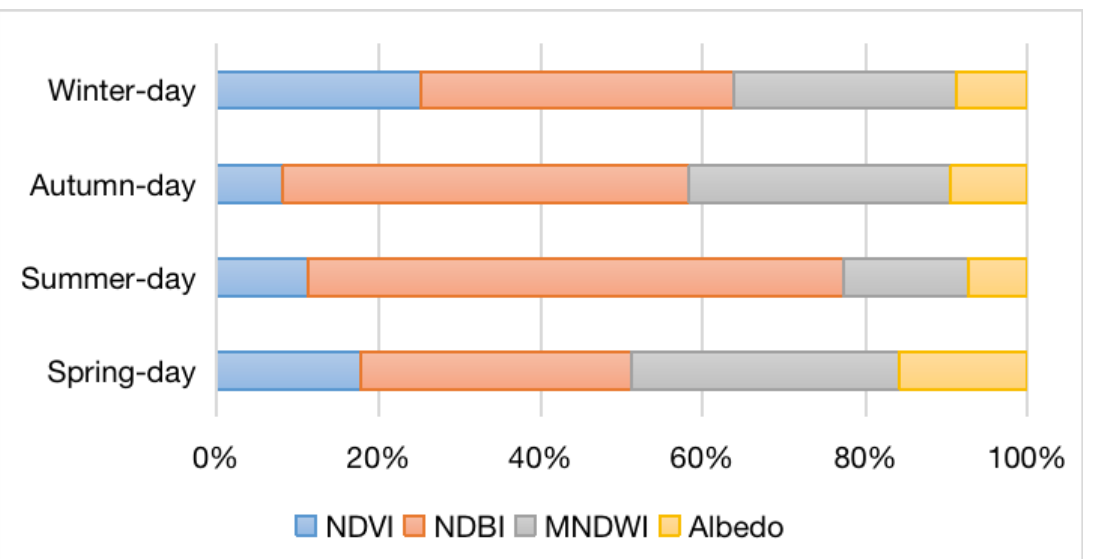
Table 6. The relationship between the selected morphology factors and LST by Pearson correlation coefficient (white lines) and local R 2 values of the MGWR (gray